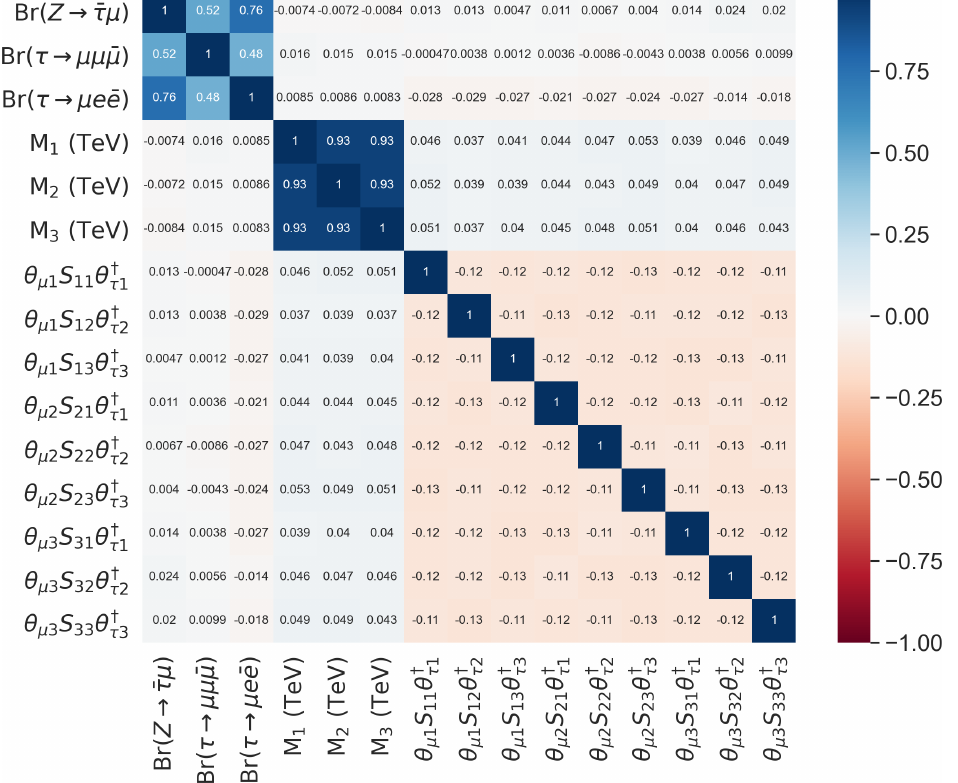
Figure 12 . Heat map that stands for the correlation matrix among ( θSθ † ) µτ − processes: Z → ¯ τµ , τ → µµ ¯ µ , τ → µe ¯ e , and their free